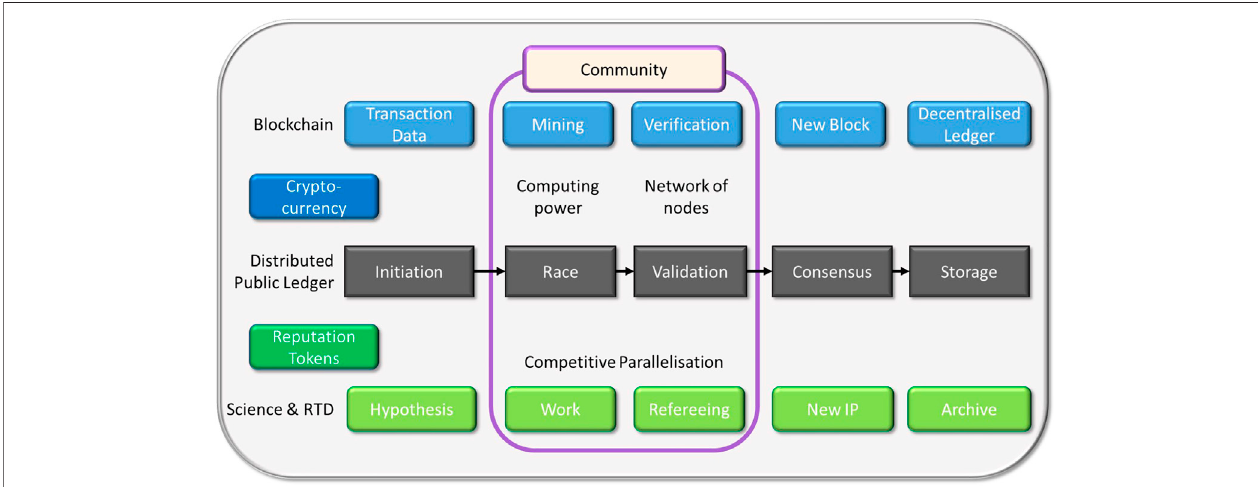
FIGURE 3 | Analogies between science and RTD and the distributed ledger technologies (based on PoW). Permissionless blockchains, such as Bitcoin or Ethereum, canbe interpreted ascooperative peer-to-peer networksofindependent players forgrowing arecord oftransactionsthatare bundled inconsecutive blocks. These packets of transaction data are competitively and redundantly created, time-stamped, veri fi ed, and selected for inclusion according to a deterministic, code- based consensus protocol. Staking PoW through participation in an enormous group mining effort, reputation by PoS and utility costs mitigate spamming and rewardcontributionstosecuringtheintegrityofthedecentralized,non-repudiableledger. “ Hashing, ” forexample,byMerkletrees,intertwinesnewwithexistingblocksto fi rmlysecuretheblockchain.The “ blocks ” inscienceandRTDmaybeIPdocumentedbyarticles,internalreports,orpatent fi llingsthatdescribenewknowledgeorknow- how thathasbeenreviewedbypeers inthecommunity.Trustand transparencyareaffordedbyreferencingandworkingaccordingtoestablished,collectivelyaccepted methods. This IP is captured, for example, as non-fungible tokens (NFTs), on public or private, quasi-eternal, and unforgeable archives curated by trusted journals, publishing houses, or patent of fi ces. Authors, inventors, validators, and referees engage in a “ race ” to be fi rst to add high-impact and well-reproducible results to this public “ ledgerofknowledge. ” Theirsuccessfuleffortsmayberewardedbydirectmonetarybene fi ts,butoftenevenstrongerincentivizedbycareeroptions,citations,and overallrecognition/prestigeofthecommunity.Spammingoftheledgerwith “ junk ” isavertedbypeerreviewandriskingreputation.Bothsystemsprovetoautonomously function without central authority to certify the integrity of data blocks and knowledge, respectively.